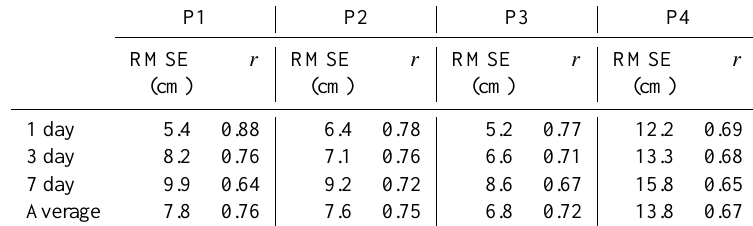
Figure 4. Observed vs. ANN-forecasted groundwater tables (P4). Table 1. Evaluation statistics of the ANN